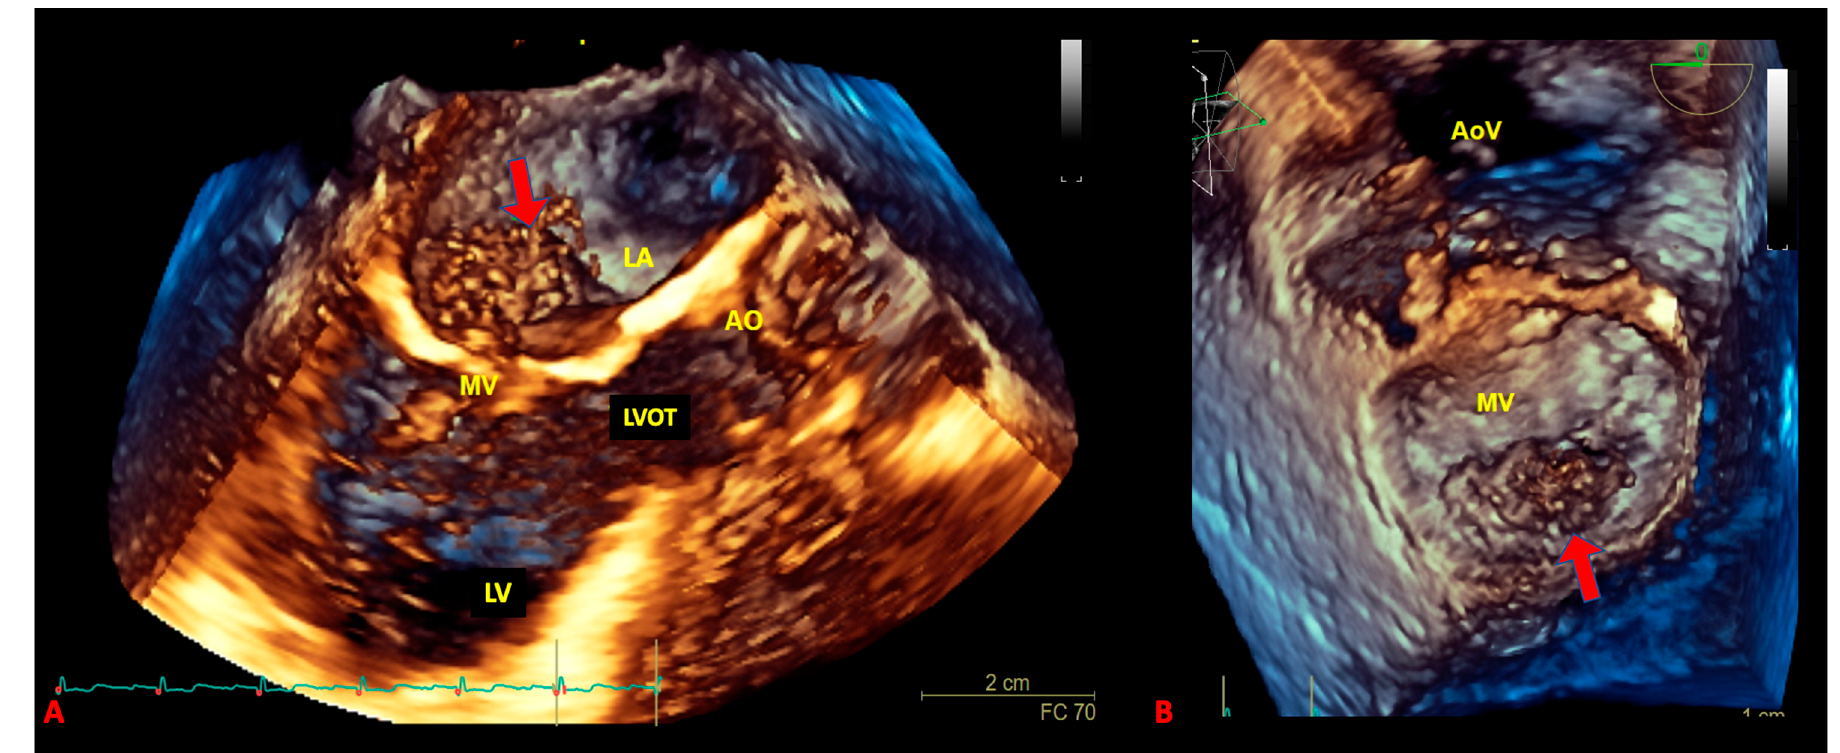
Figure 4. Three-dimensional transoesophageal echocardiography in long-axis view ( A ) and en-face view ( B ) showing intracardiac sarcoma involving the atrial side of the posterior leaflet (P1 and P2 scallops) of the mitral valve. The arrows (red) indicate the cancer mass.AO: aorta; AoV: aortic valve; LA: left atrium; LV: left ventricle; LVOT: left ventricular outflow tract; MV: mitral valve.